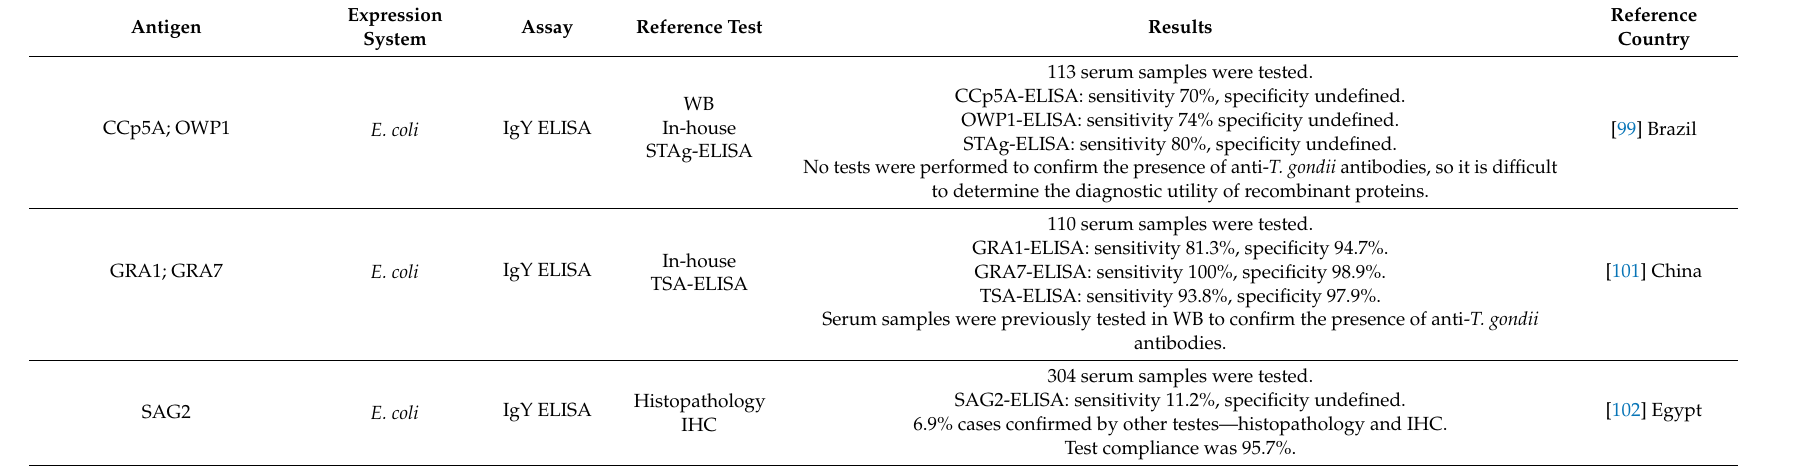
Table 9. Recombinant antigens used in detection of anti -T. gondii antibodies in chicken serum